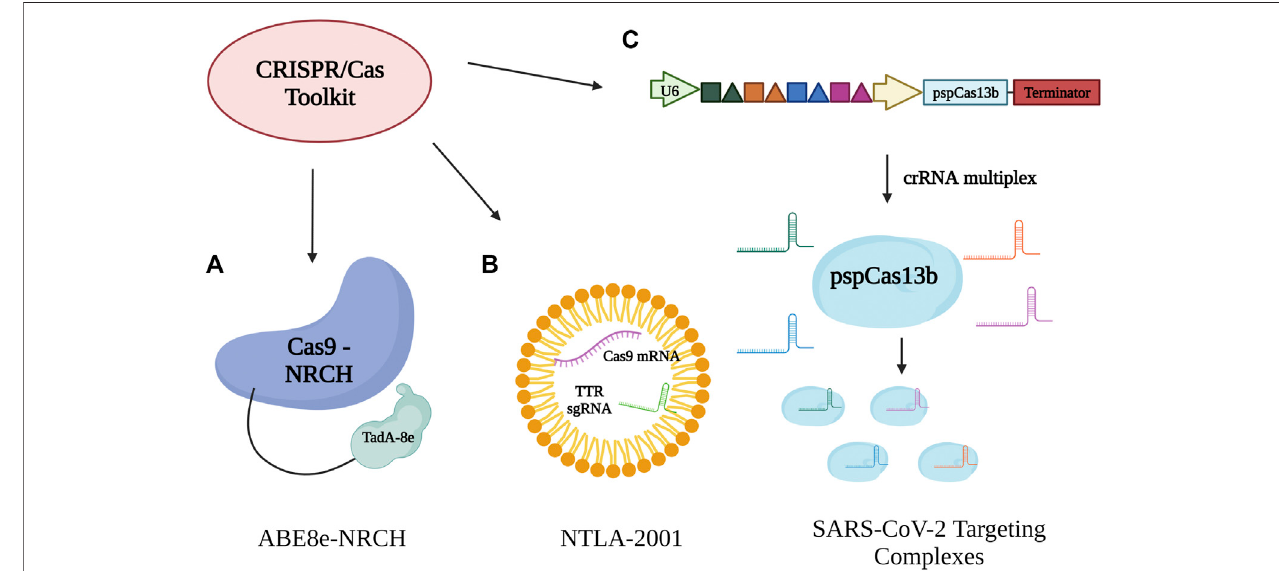
FIGURE 3 | Therapeutic applications for CRISPR/Cas systems. (A) A specialized adenine base editor composed of Cas9-NRCH bound to a TadA-8e domain. ABE8e-NRCH converts the pathogenic variant of the sickle cell disease allele into a non-pathogenic variant. (B) Lipid nanoparticle delivery of Cas9 mRNA and transthyretin-targeting(TTR)gRNAfortreatmentofATTRamyloidosiswiththegoalofreducingbothmutantandwildtypelevelsoftransthyretinprotein. (C) SARS-CoV-2 targeting complexes. A set of four targeting crRNAs is utilized in combination with pspCas13b in order to reduce the virus ’ s chance for escape through mutation and daughter strain proliferation. Main targeted sites are conserved regions and sequences of